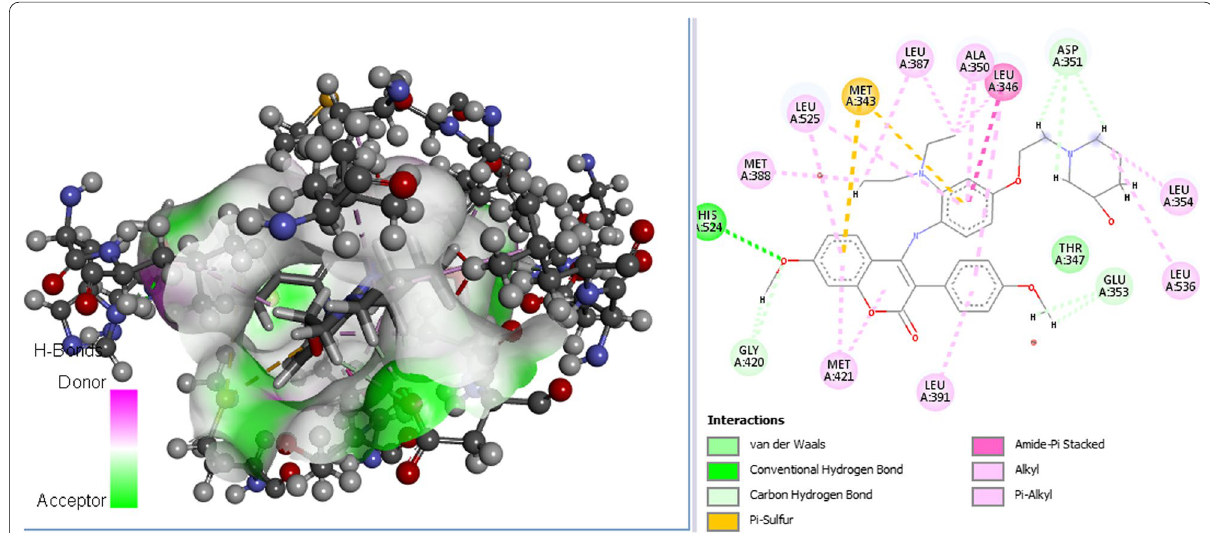
Fig. 14 3D and 2D binding modes of designed compound 12 with the active pocket of the ER + receptor